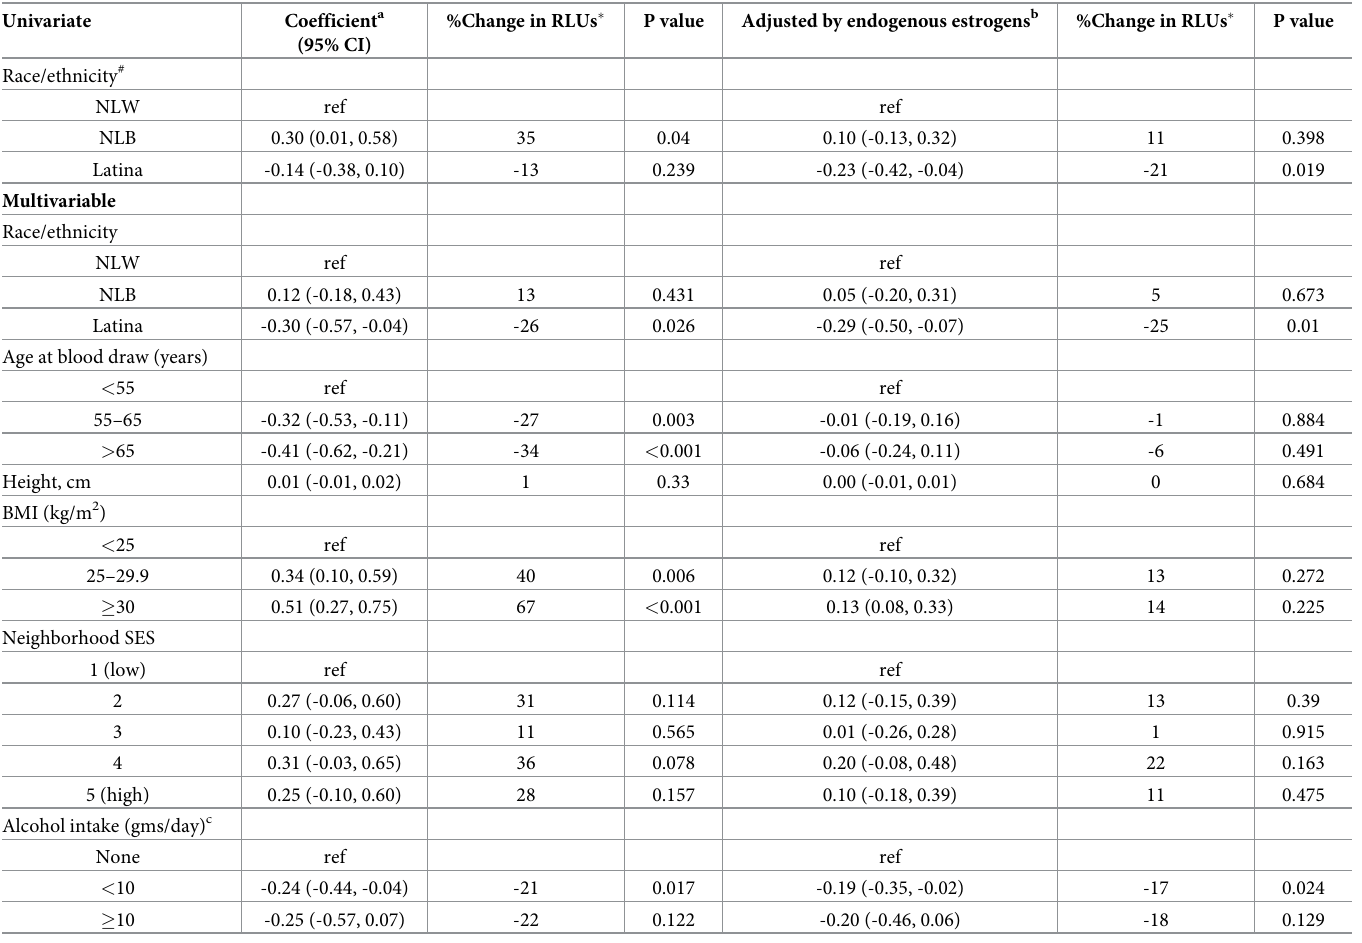
Table 2. Association of estrogenic activity with lifestyle and demographic factors in all women (N = 488) using univariate and multivariable analyses.